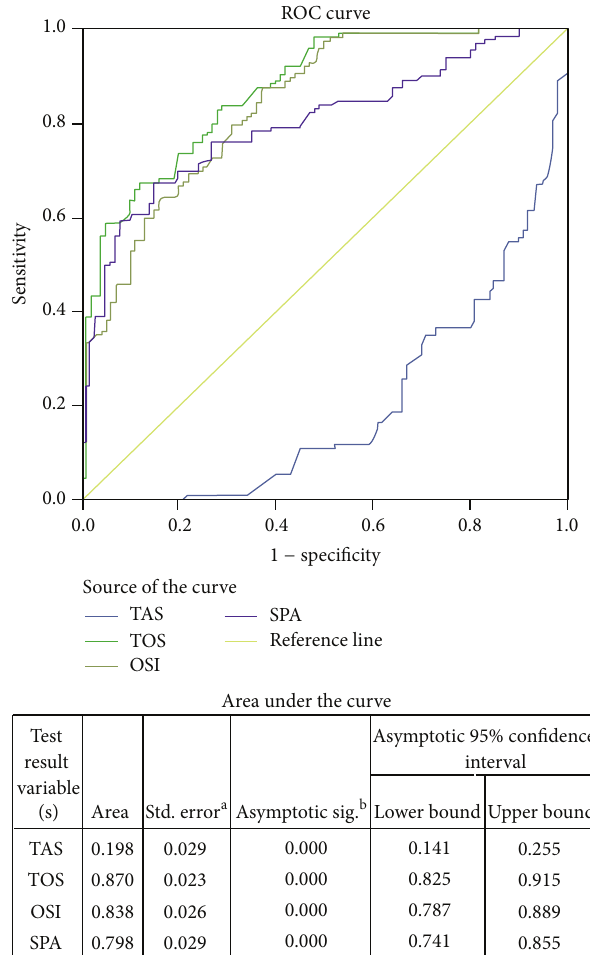
Figure 1: Receiver operating characteristic (ROC) curve of SPA, TOS, TAS, and OSI at cutoff value ≥ 60.78 mmolmin −1 L −1 , ≤ 0.81 mmol Trolox Eq./L, and ≥ 10.24AU, ≥ 16.64 𝜇 molH 2 O 2 Eq./L, respectively, for the prediction of kidney damage (either DN or ESRD or